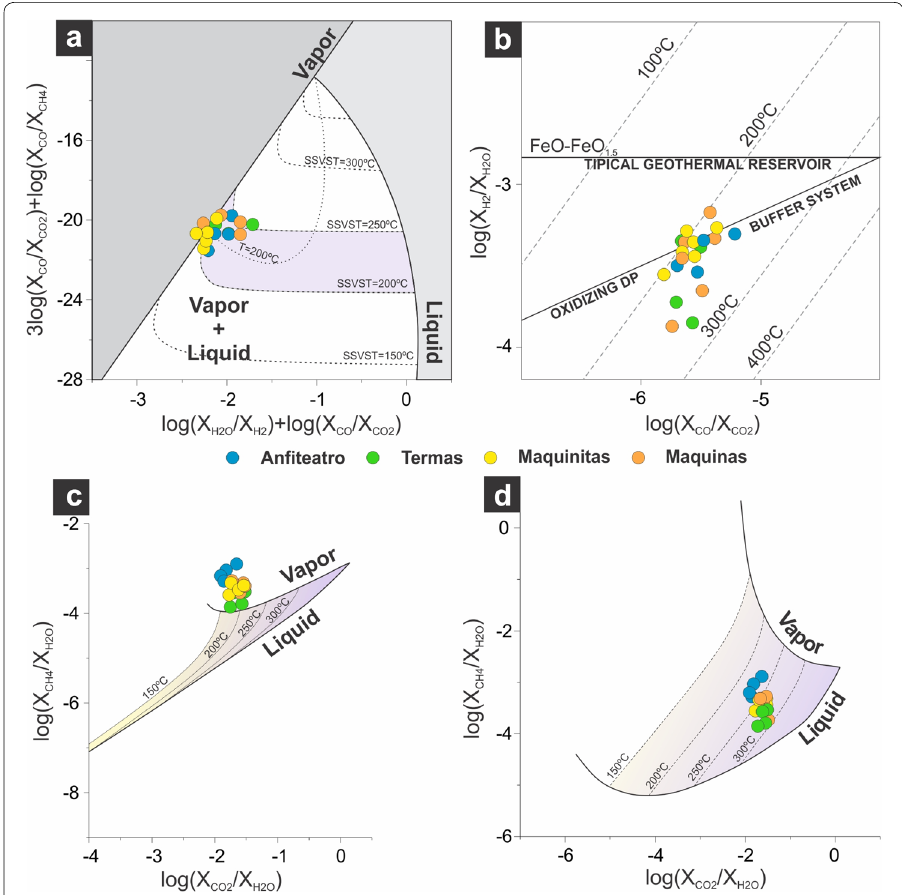
Fig. 7 Chemical fluid approach to infer the physicochemical features of the geothermal reservoir in Copahue, according to Agusto et al. (2013). Gas discharge composition database from Jurío (1977), Panarello (2002), Martini et al. (1997), Agusto et al. (2013), and Tardani et al. (2016). a Binary diagram for the CO–CO 2 – H 2 –H 2 O system. Theoretical single-saturated vapor phase and single-saturated liquid phase are shown. b log(XH 2 /XH 2 O) vs. log(XCO/XCO 2 ) binary diagram with theoretical compositions of the vapor in equilibrium controlled by the DP redox buffer (D’amore and Panichi 1980) and the typical FeO–FeO 1.5 geothermal buffer reaction (Giggenbach 1987). c log(XCH 4 /CH 2 O) vs. log(XCO 2 /XH 2 O) binary diagram; vapor and liquid phase fields controlled by DP redox buffer are also shown (D’amore and Panichi 1980). d log(XCH 4 /CH 2 O) vs. log(XCO 2 /XH 2 O) binary diagram; theoretical compositions of equilibrated vapor and liquid phases at redox conditions controlled by the FeO–FeO 1.5 redox buffer are